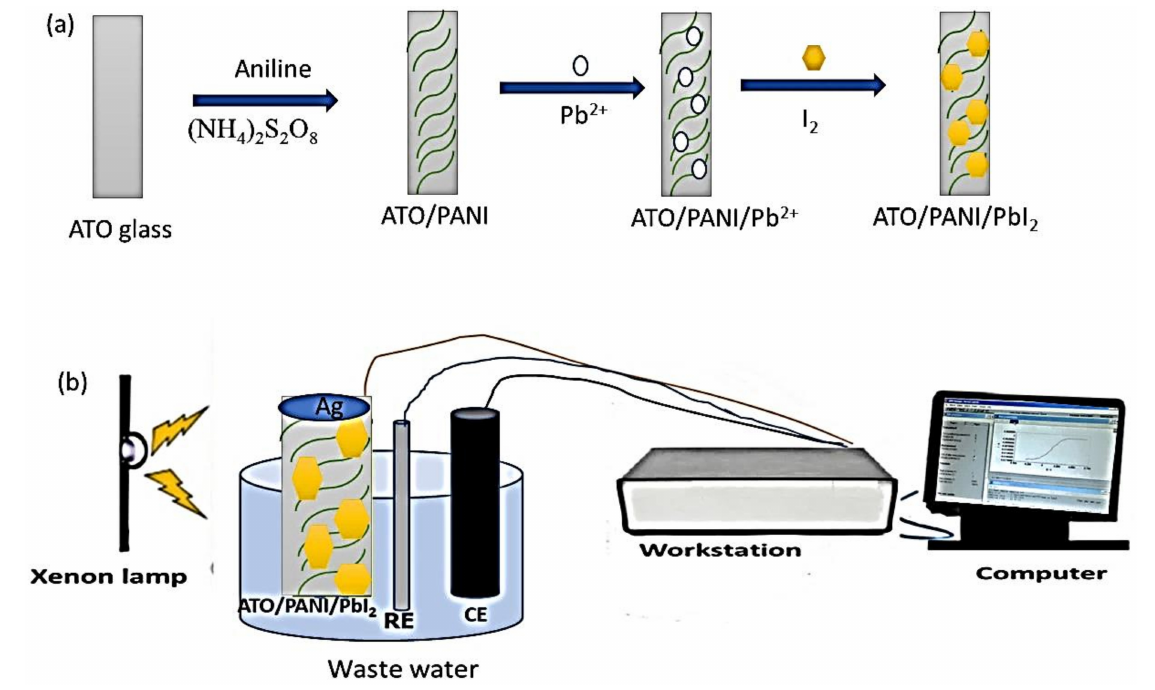
Figure 1. The schematic diagram for the preparation of ATO/PANI/PbI 2 nanocomposite electrode., aniline polymerization using the oxidant (NH) 2 S 2 O 8 , then the PbI 2 deposition in two steps ( a ) and ( b ) the electrochemical measurements using the three-electrode cell under Xenon